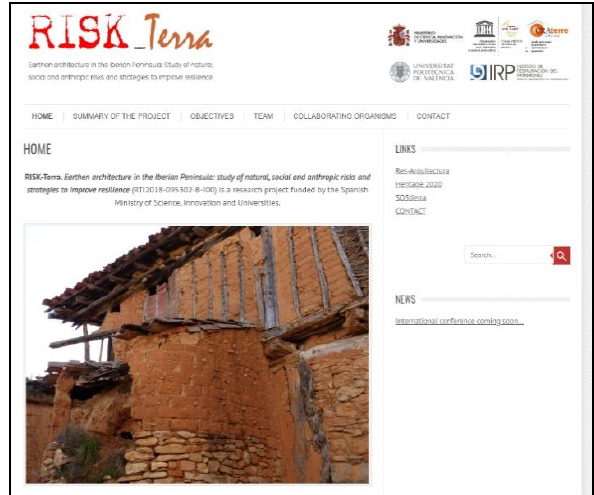
Figure 5. Risk-Terra Research Project